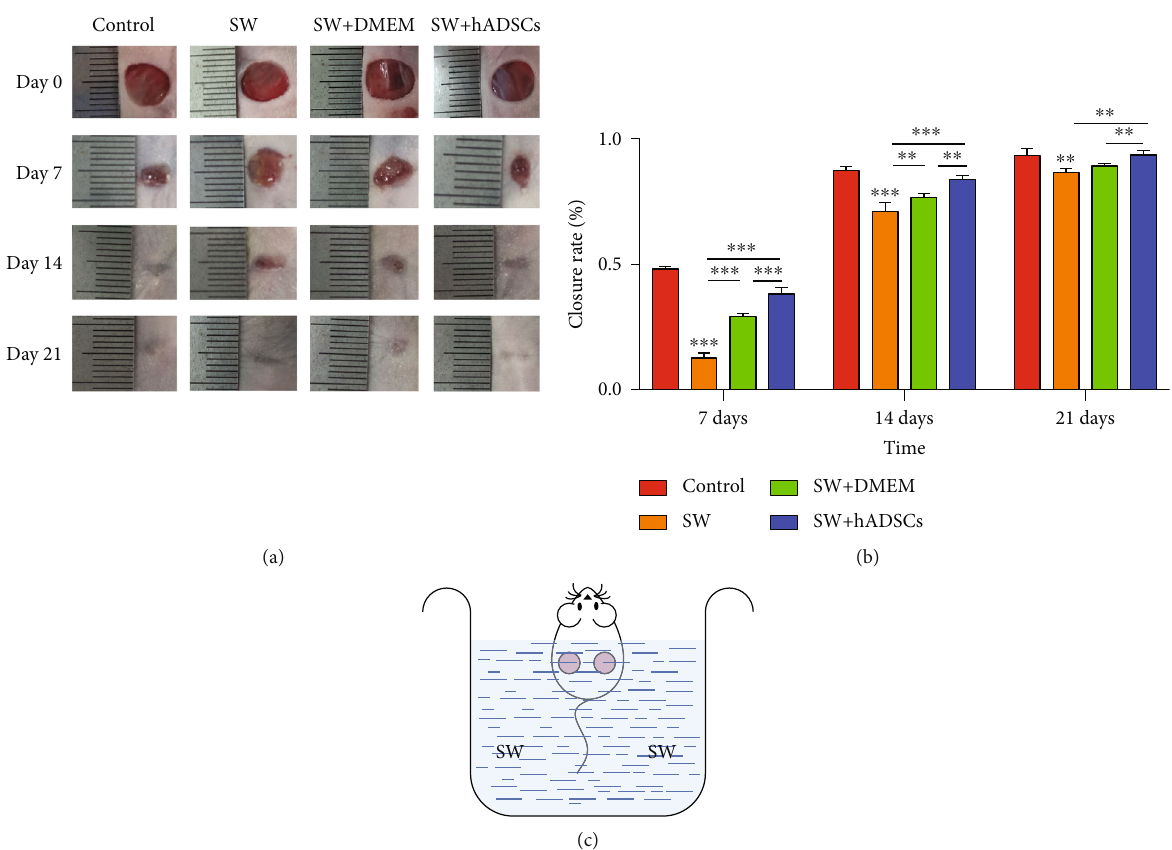
Figure 1: In vivo observation of wound healing after SW and hADSC treatments. The wound area was measured and calculated on days 7, 14, and 21 after injury with Image-Pro Plus 6.0 software (a). The SW-immersed wounds showed a slower rate of reepithelialization and closure during the healing period on the 7th and 14th days, while the hADSC injection signi fi cantly accelerated the healing of SW-immersed wounds (b). ∗ P < 0 : 05 , ∗∗ P < 0 : 01 , and ∗∗∗ P < 0 : 001 . Schematic diagram of the seawater immersion model